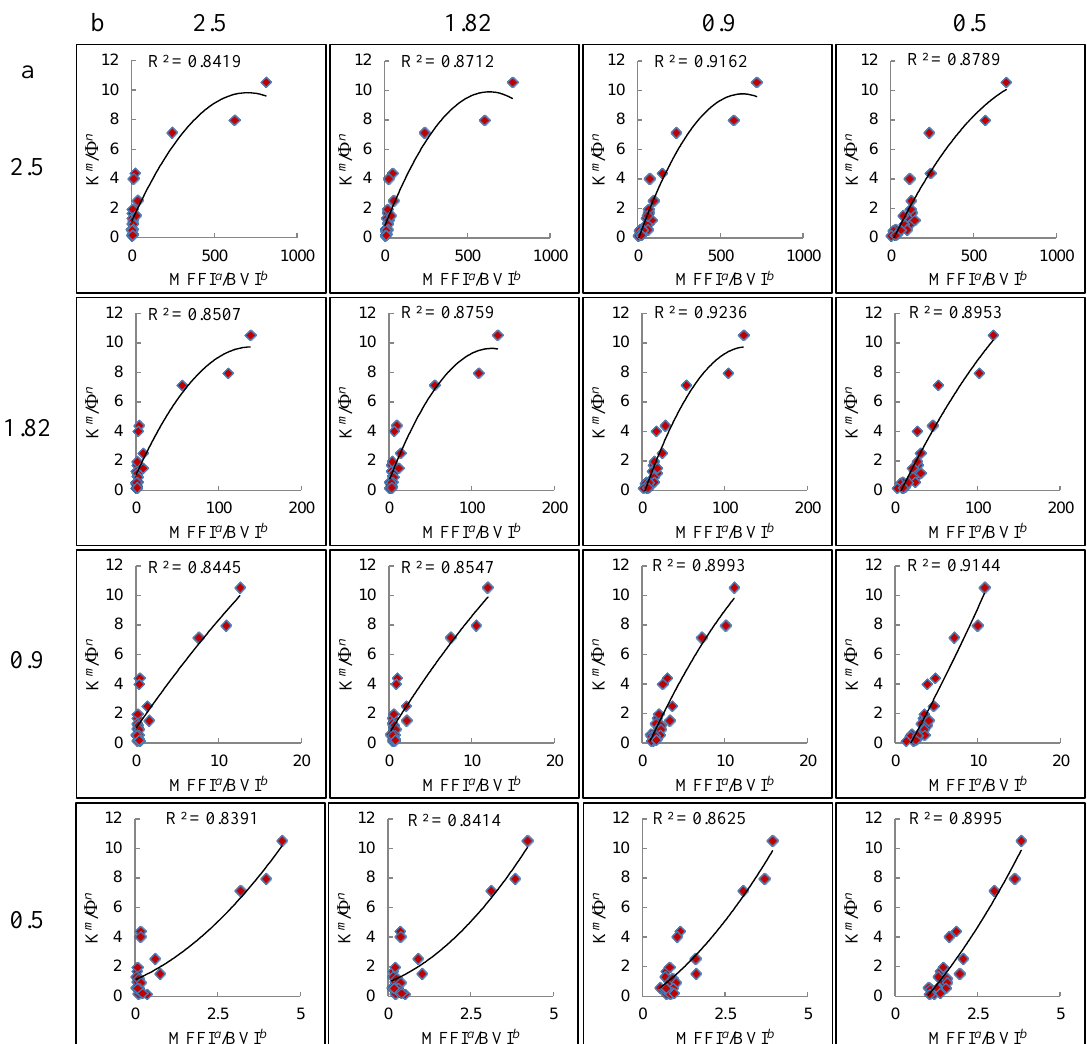
Figure 6. The partial polynomial statistical results of the correlation between the ratio of movable porosity to irreducible porosity, and the RQI as the a and b values change when m is 1.02 and n is 0.03.